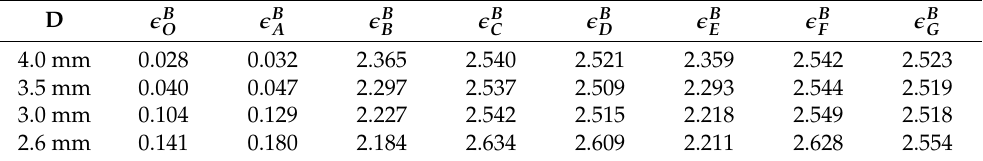
Table 6. Logarithmic strain at different positions of triaxial geogrid after transverse